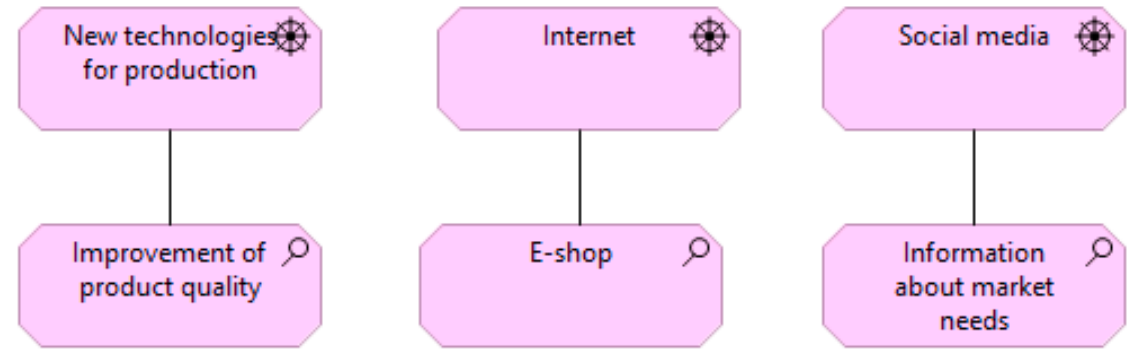
Figure 5. Analysis of external factors and technology.